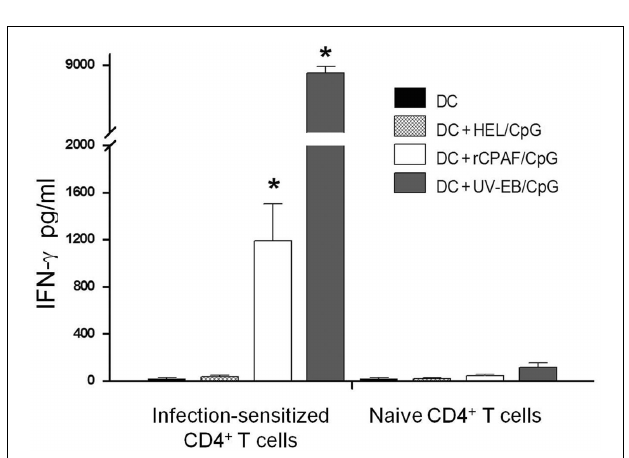
FIGURE 3 | Infection-sensitized CD4 + T cells secrete IFN- γ in response to BMDCs pulsed with rCPAF + CpG or UV-EB + CpG. CD4 + T cells were collected from naïve mice or those mice ( n = 3) that had resolved a Chlamydia genital infection. Purified CD4 + T cells were incubated in the presence of unpulsed BMDC, and BMDC pulsed with HEL + CpG, rCPAF + CpG, or UV-EB + CpG for 72h, and supernatants was collected. IFN- γ in supernatants was measured by ELISA. All experiment were performed in triplicate and repeated on two separate occasions with similar results.The results represent the mean ± SEM from one representative experiment. ( ∗ ) Statistically significant differences ( p < 0.01; ANOVA) between the indicated group and HEL + CpG-pulsed BMDC are shown.